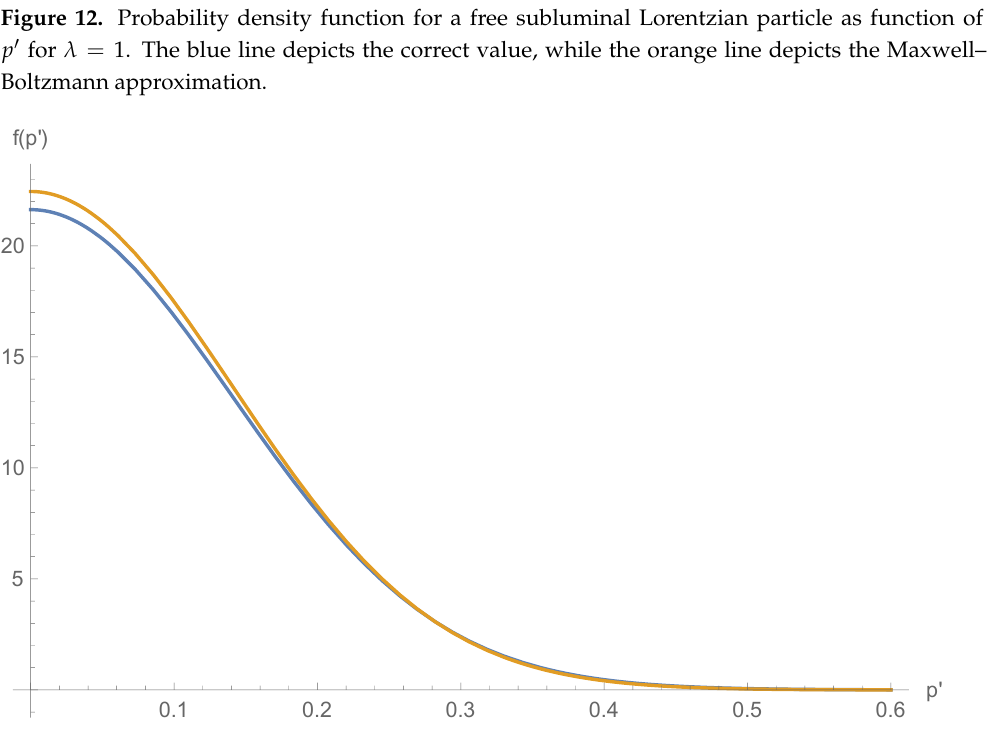
Figure 13. Probability density function for a free subluminal Lorentzian particle as function of p (cid:48) for λ = 50. The blue line depicts the correct value, while the orange line depicts the Maxwell– Boltzmann